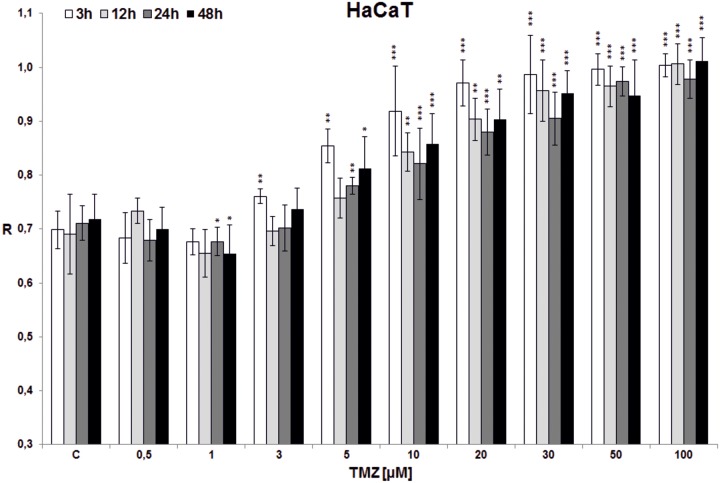
The effect of TMZ on total DNA methylation of HaCaT cell line.The analysis was performed after 3 (white bars), 12 (light grey bars), 24 (dark grey bars) and 48 (black bars) hrs of incubation in a given TMZ concentration (0.5–100 μM). Control cells (C) were treated with DMSO only. The R values are means from three experiments ±SD. Asterisks indicate a significant difference (*p < 0,05, **p < 0,01, ***p < 0,001) from the control (DMSO) value. In all incubation times the hypermethylation effect is seen over TMZ concentration of 5 μM. No hypomethylation in lower concentrations was detected.